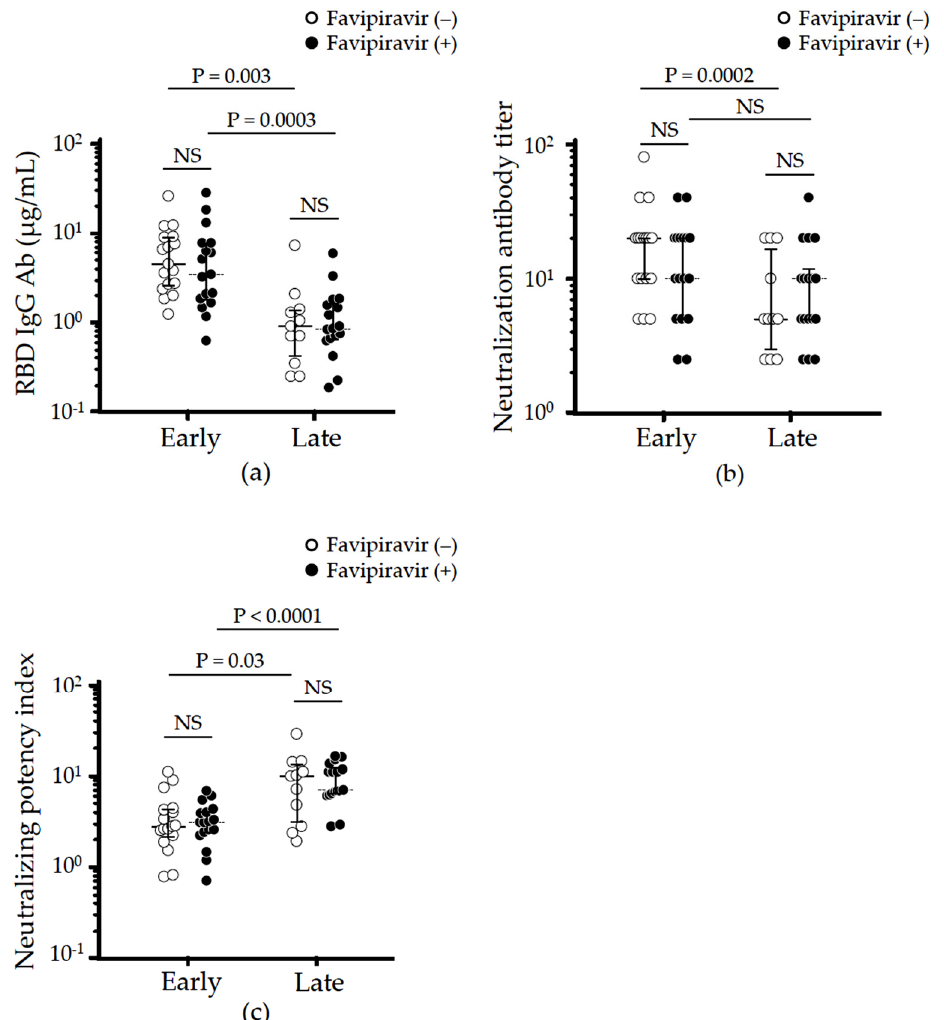
Figure 3. Effect of favipiravir on virus-neutralizing antibody production, duration, and maturation in patients with moderate COVID-19. The highest values of ( a ) RBD IgG antibody production, ( b ) neutralizing antibody titer, and ( c ) neutralizing potency index in early ( ≤ 180 days after symptom onset) versus late (>180 days after symptom onset) convalescent serum from each recovered patient were analyzed and compared. Statistical analyses were done using the Wilcoxon test or paired t -test as appropriate for early vs. late in the same treatment group and Mann–Whitney U-test or t -test as appropriate for case ( • ) vs. control ( ◦ ) in the same time phase. NS: not